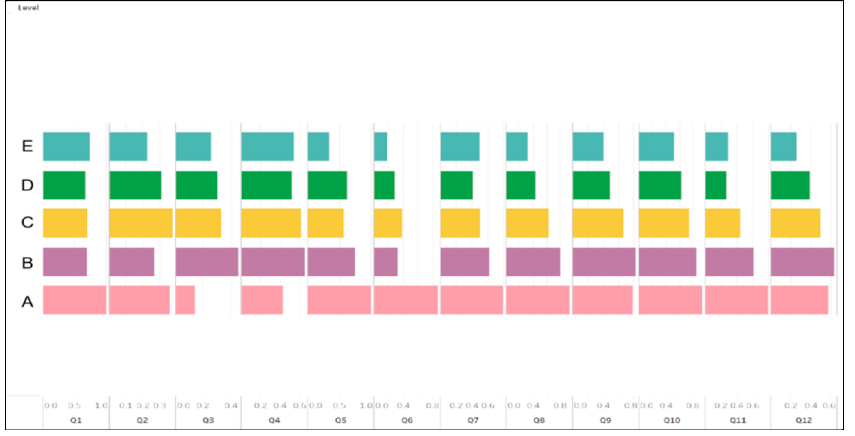
Figure 10. Questionnaire — user behavior 5 intervals.